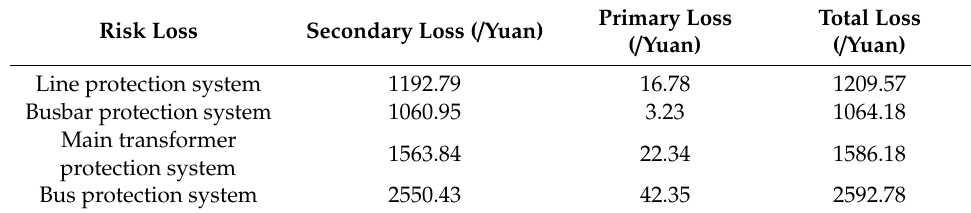
Table 8. Risk loss of protection